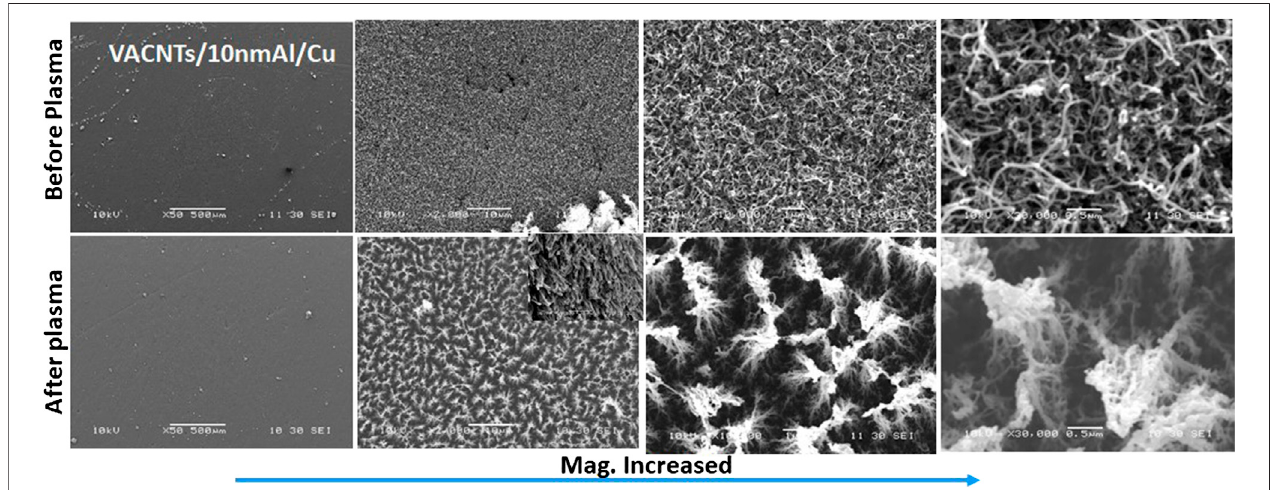
FIGURE 5 | Top view SEM images of VACNT layer: before and after 15 min plasma treatment. (Scale bar from left to right (cid:2) 500, 10, 1.0, 0.5 µm.)